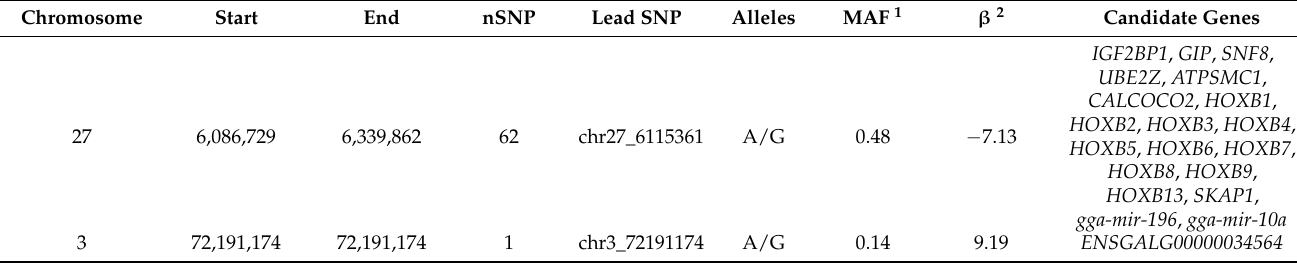
Table 1. Candidate genes in the significant region of chromosome 3 and